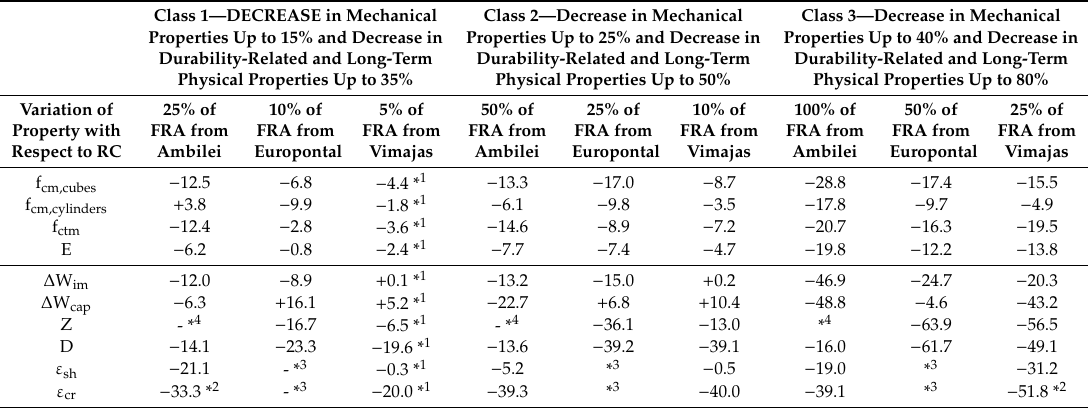
Table 10. Validation of the maximum incorporation ratios of fine